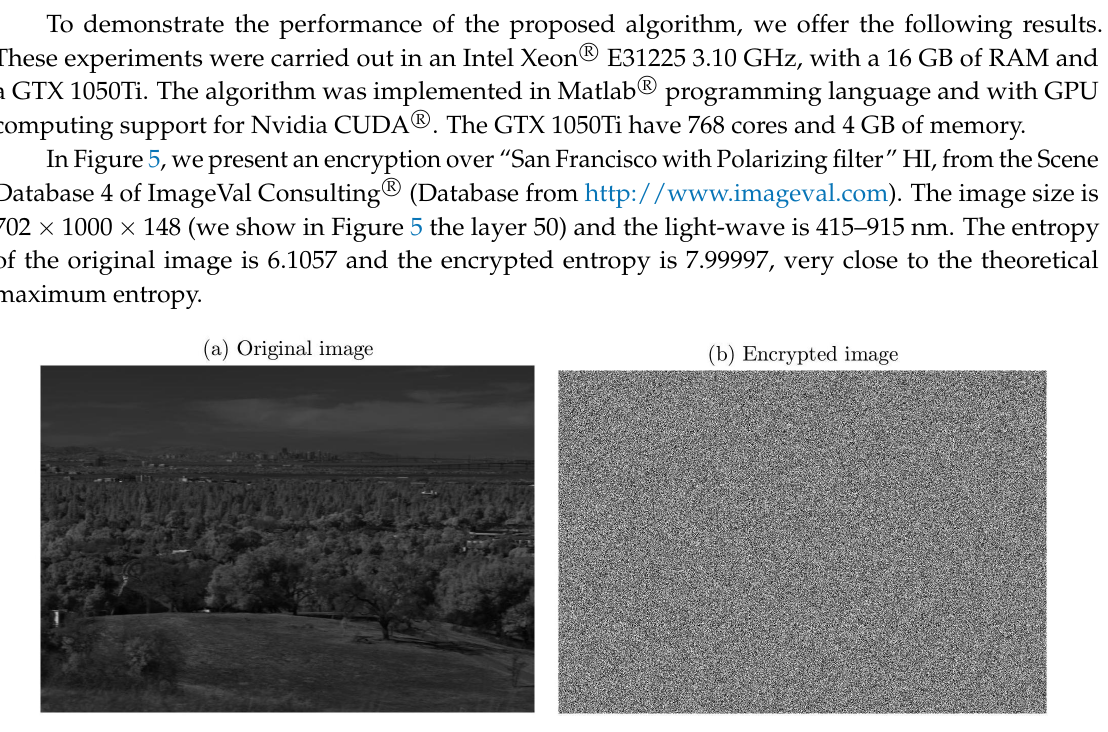
Figure 5. Experiment 1. Original and encrypted